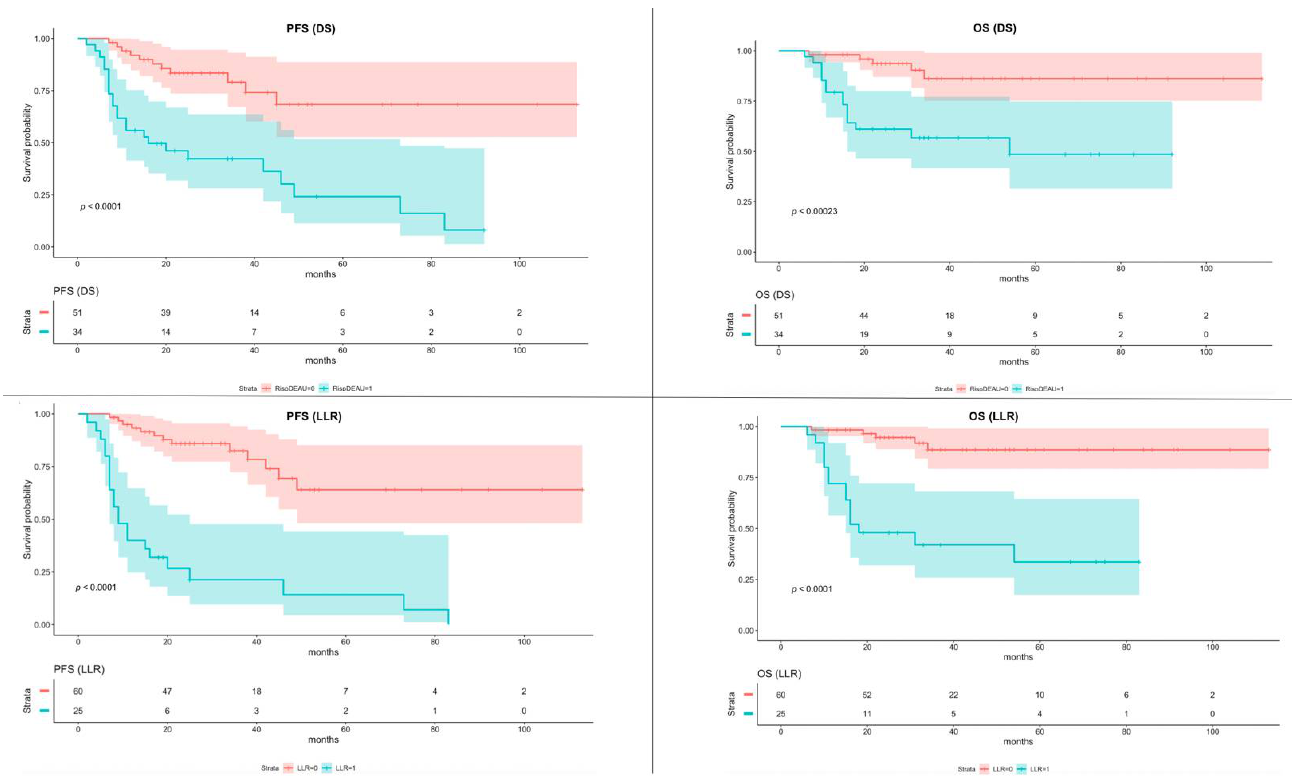
Figure 3. Kaplan–Meier of Progression-Free Survival (PFS) and Overall Survival (OS) according to the Deauville Score (DS) and Lesion-to-Liver SUVmax ratio (LLR) in sub-group of patients underwent R-CHOP scheme. The color bands around the median values of PFS and OS represent the 95% confidence interval. Table 2. The multivariate analysis for PFS and OS includes qualitative and semi-quantitative PET parameters and baseline clinical patients’ characteristics.